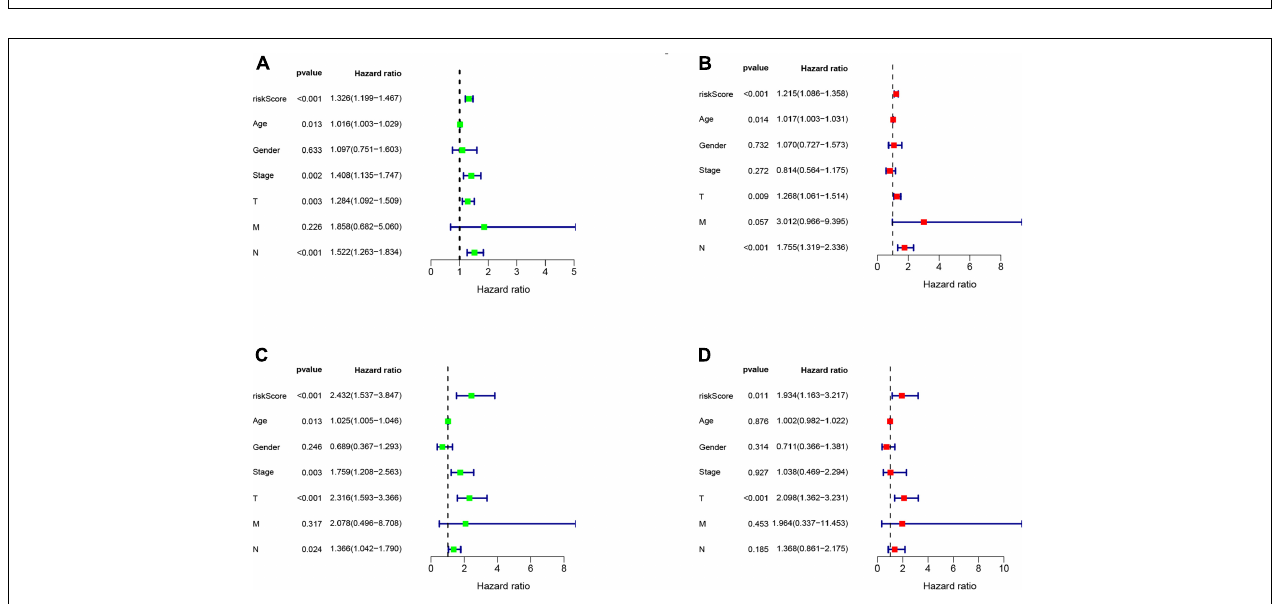
FIGURE 4 | The Cox regression analysis of risk score, age, gender, T, N, M, and tumor stage in training (A,B) , testing (C,D) cohort.